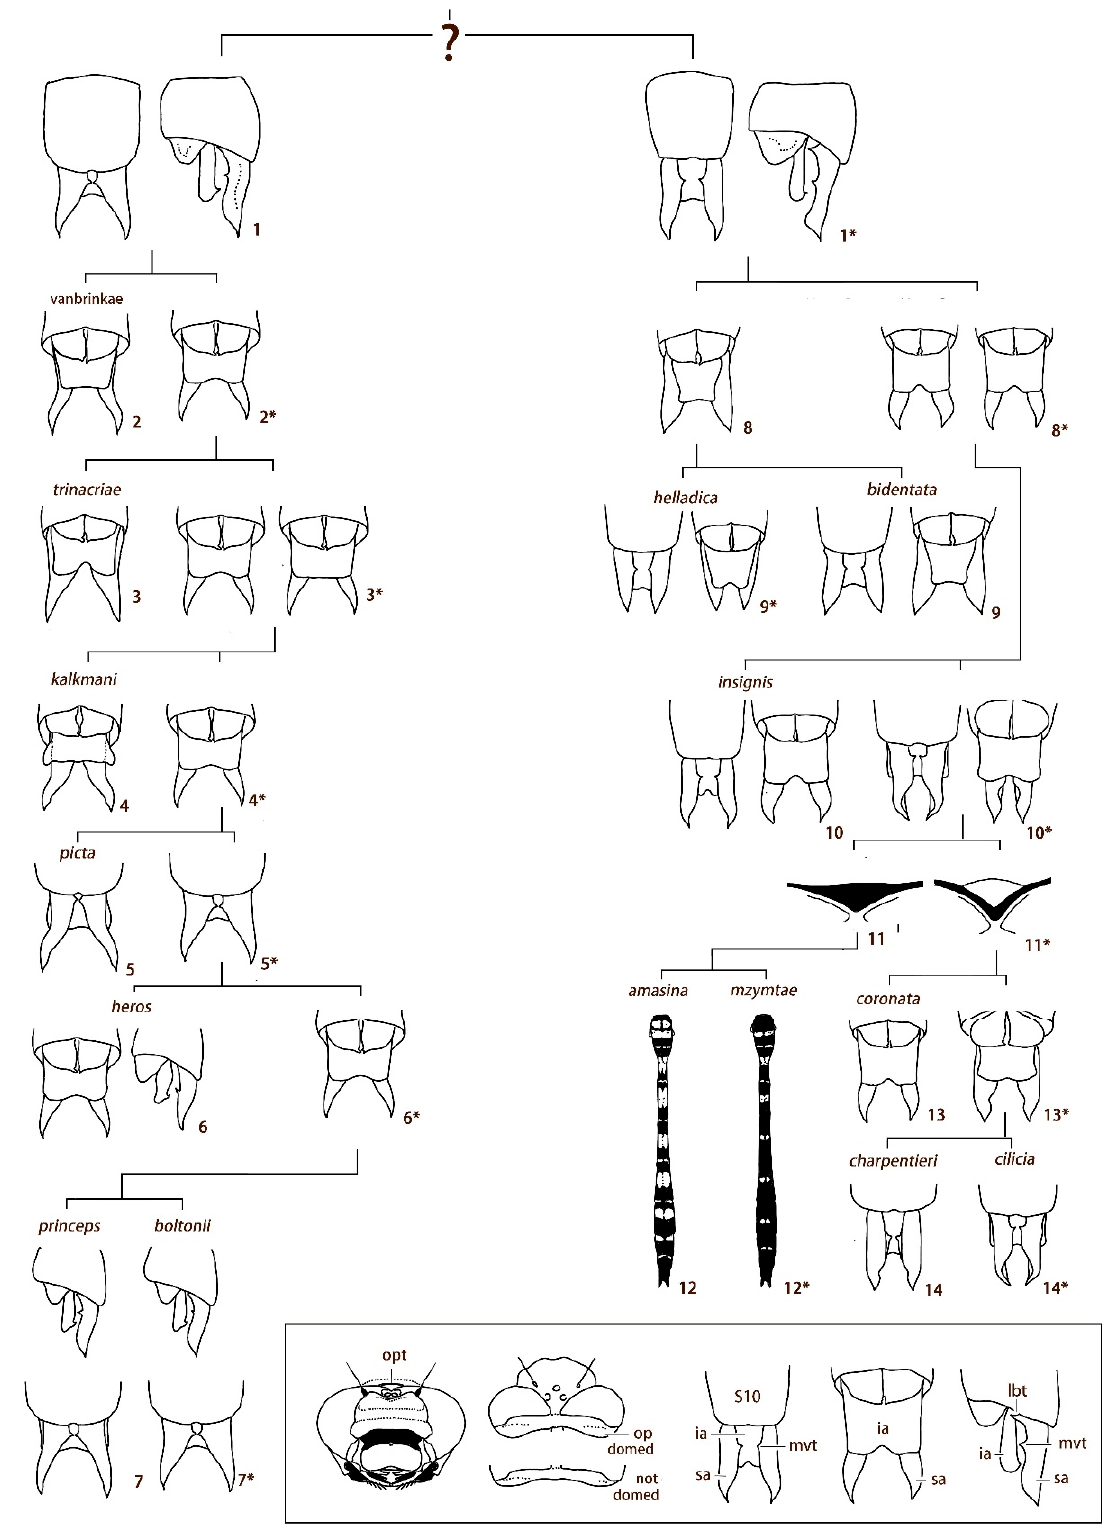
Figure 23. Dichotomous identification tree for all Western-Palaearctic Cordulegaster (males, graphically represented features in the text, additional features in square brackets).